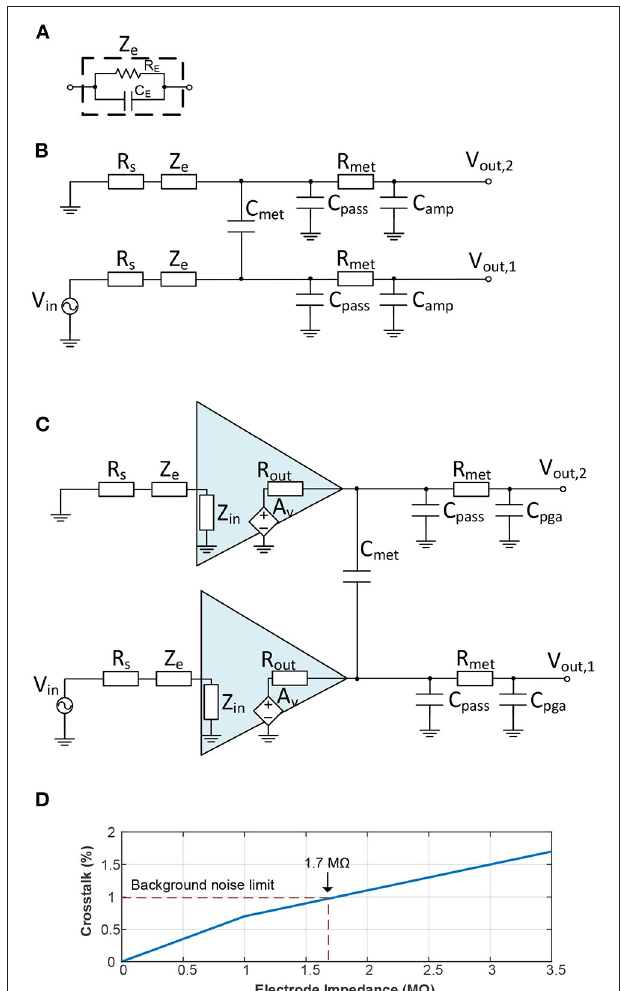
FIGURE 2 | Crosstalk models for electrode-AFE interface. (A) Equivalent electrode impedance model. (B) Equivalent circuit model for electrode crosstalk without active electrode-AFE interface. (C) Equivalent circuit model for electrode crosstalk with active electrode-AFE interface. (D) Crosstalk at the electrode-AFE interface against the electrode impedance ( Du et al.,